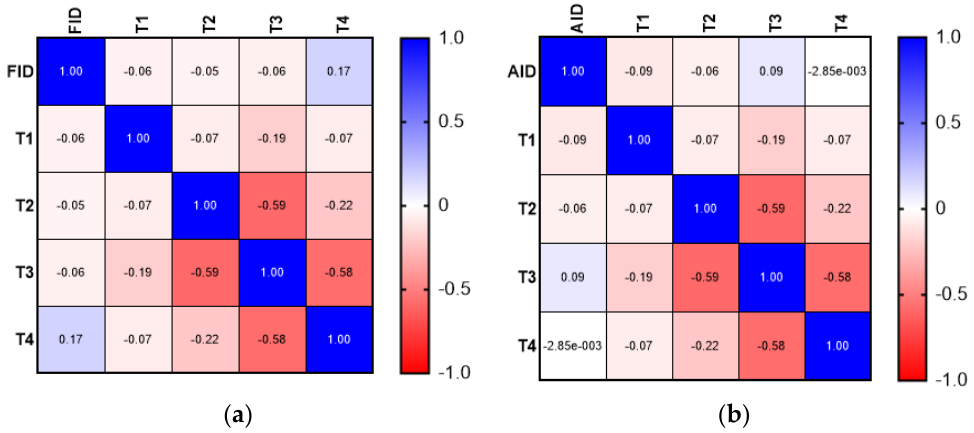
Figure 1. Comparison between FID and AID: ( a ) correlation matrix for FID and T stage; ( b ) correlation matrix for AID and T stage.